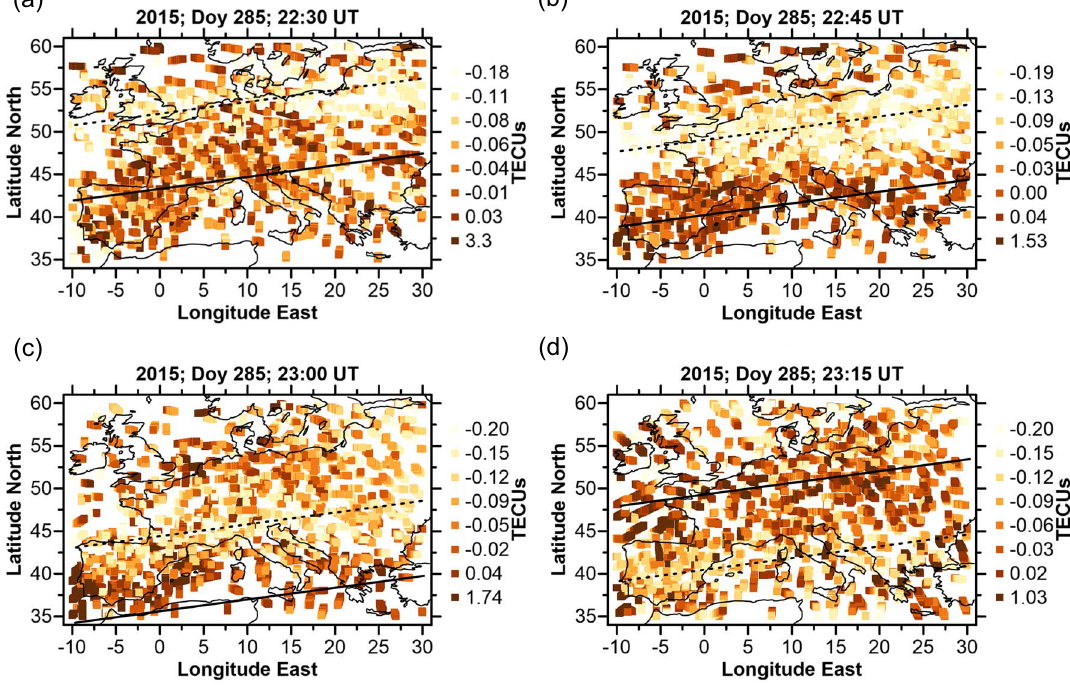
Fig. 5. Snapshots of the perturbation TEC maps estimated over Europe (a) 22:30 UT; (b) 22:45 UT; (c) 23:00 UT; and (d) 23:15 UT of 12 October 2015. Tilted solid and dashed lines in the plots indicate the valleys and crests of the TEC disturbance respectively.